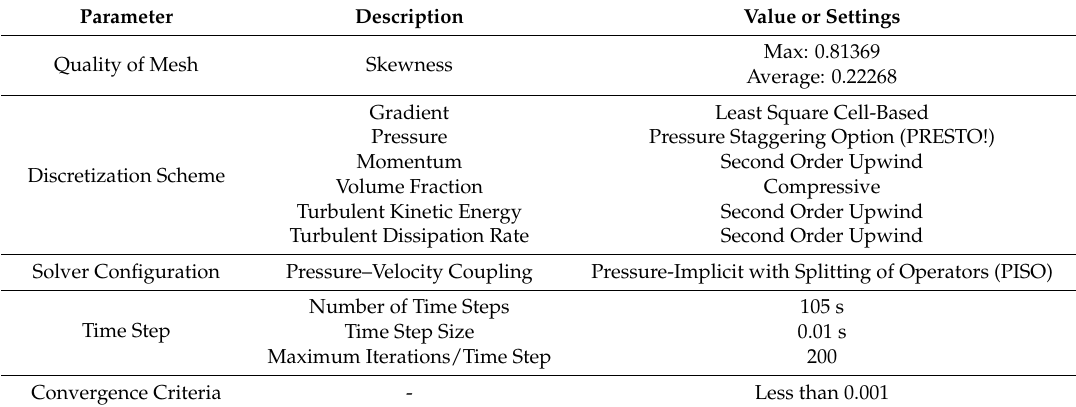
Figure 7. Separator model and separator with mesh. Table 2. Computational fluid dynamics (CFD) settings for the separator.